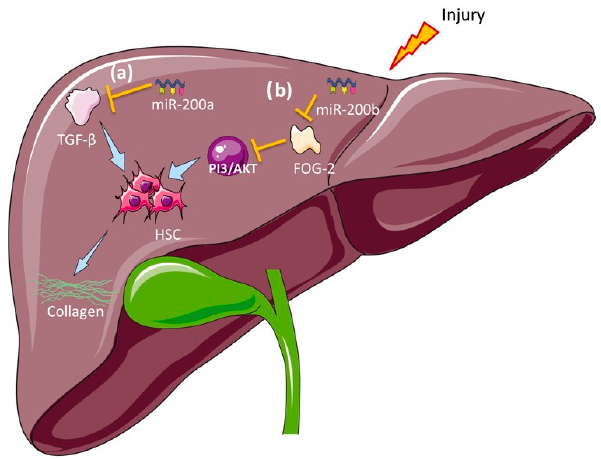
Figure 4. Proposed role of miRNA biomarkers in BA. ( a ) miRNA-200a is involved in the inhibition of TGF- β induced HSC activation and collagen synthesis, suggesting an anti-fibrotic role; ( b ) miRNA-200b enhances the PI3K/Akt signalling by targeting FOG2, which activates HSCs and collagen synthesis. TGF- β : transforming growth factor β ; HSC: hepatic stellate cells; FOG2: friend of GATA protein 2.